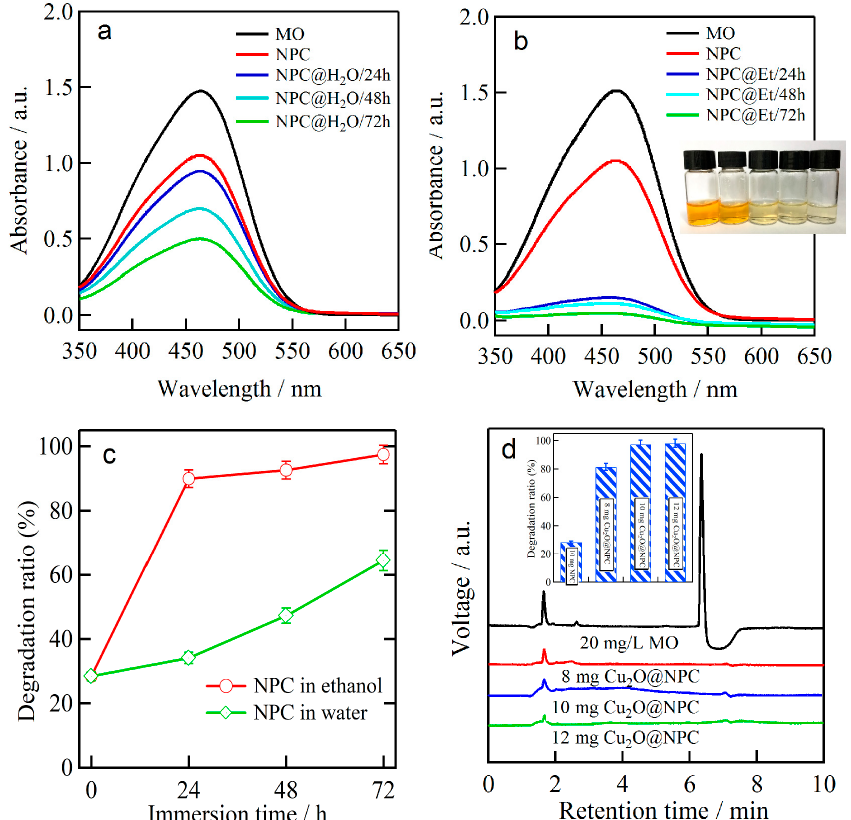
Figure 7. UV-Vis spectra of MO degradation of octahedral cupric oxide (Cu 2 O) and Nanoporous Cu (NPC) ( a ), Cu 2 O nanobelts and NPC ( b ) colour change of MO solution (inset in b), degradation amount of 20 mg/L MO photodegraded by Cu 2 O nanobelts and NPC and octahedral Cu 2 O and NPC for different times ( c ) and HPLC chromatograms of MO after photodegradation by Cu 2 O@NPC with load of 8, 10, and 12 mg L − 1 ( d ). The inset bar plots in d are the photodegradation ratio of corresponding NPC and Cu 2 O@NPC from UV-Vis spectrometer. Et stands for ethanol. NPC@H 2 O stands for the NPC immersion in water; NPC@Et stands for the NPC immersion in ethanol, Cu 2 O @NPC stands for Cu 2 O nanobelts and NPC.